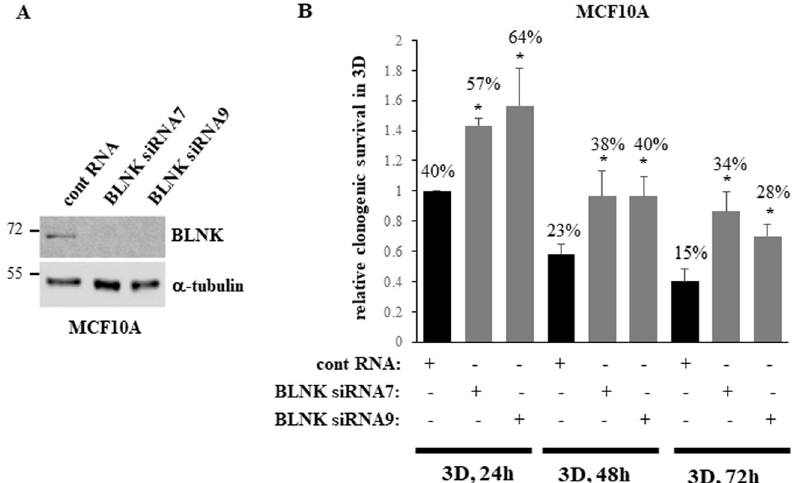
Fig. 3 Detachment-induced BLNK upregulation is required for anoikis of non-malignant breast epithelial cells. A MCF10A cells transfected with 100 nM control RNA (cont RNA) or BLNK-speci fi c siRNA (BLNK siRNA) 7 or 9 were detached for 3 h (3D) and assayed for BLNK expression by western blotting. α -tubulin was used as a loading control. B MCF10A cells treated as in A were allowed to form colonies in monolayer immediately or after being detached for the indicated times. The ratio of colony number formed by the cells detached for each time period to that formed by the cells plated in monolayer immediately after transfection is shown in each case. This ratio observed for the cells detached for 24 h was designated as 1.0. The data represent the average of three independent experiments plus the